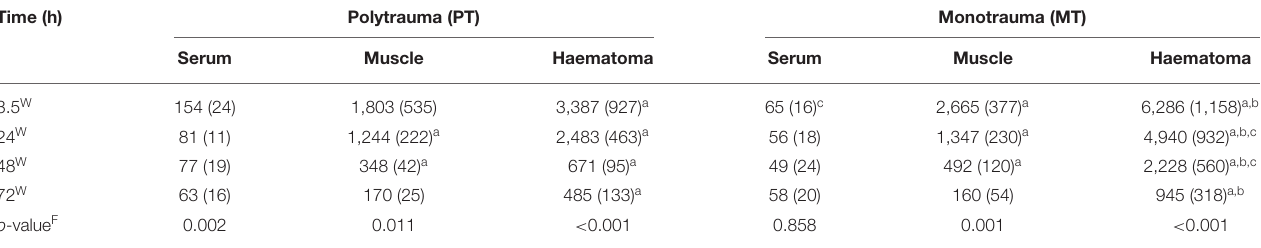
TABLE 1 | Systemic and local concentrations of IL-6 pg/ml; a p < 0.05 compared to serum concentrations, b p < 0.05 compared to muscle concentrations, c p < 0.05 compared to PT.